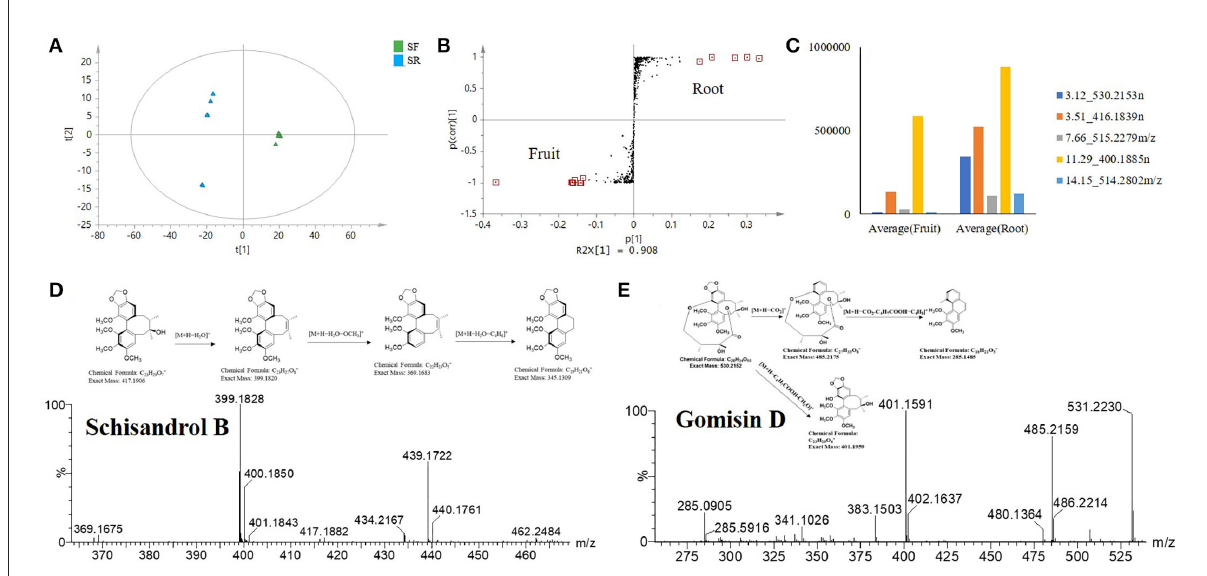
FIGURE7 Selected S. chinensis potential biomarkers from the comparative analysis of SR and SF based on the S-plot. (A) OPLS-DA. (B) S-plot showing the selected markers. (C) Variable averages by a group of selected potential marker compounds. (D) Cracking process of schisandrol B. (E) Cracking process of gomisin